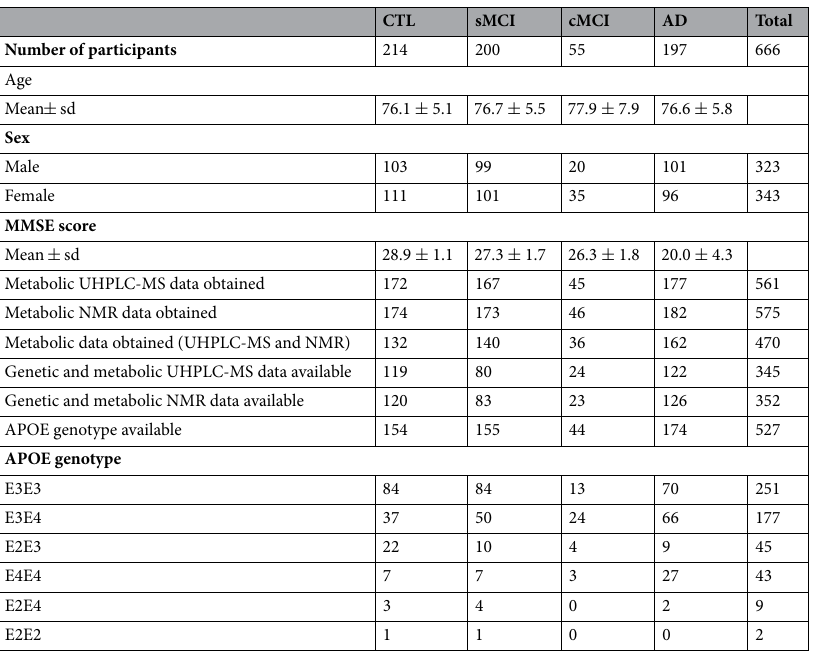
Table 1. Overview of study participants. CTL normal cognition (control) participants, sMCI stable mild cognitive impairment, cMCI mild cognitive impairment converting to dementia, AD participants with Alzheimer’s disease, MMSE Mini-Mental State Examination.